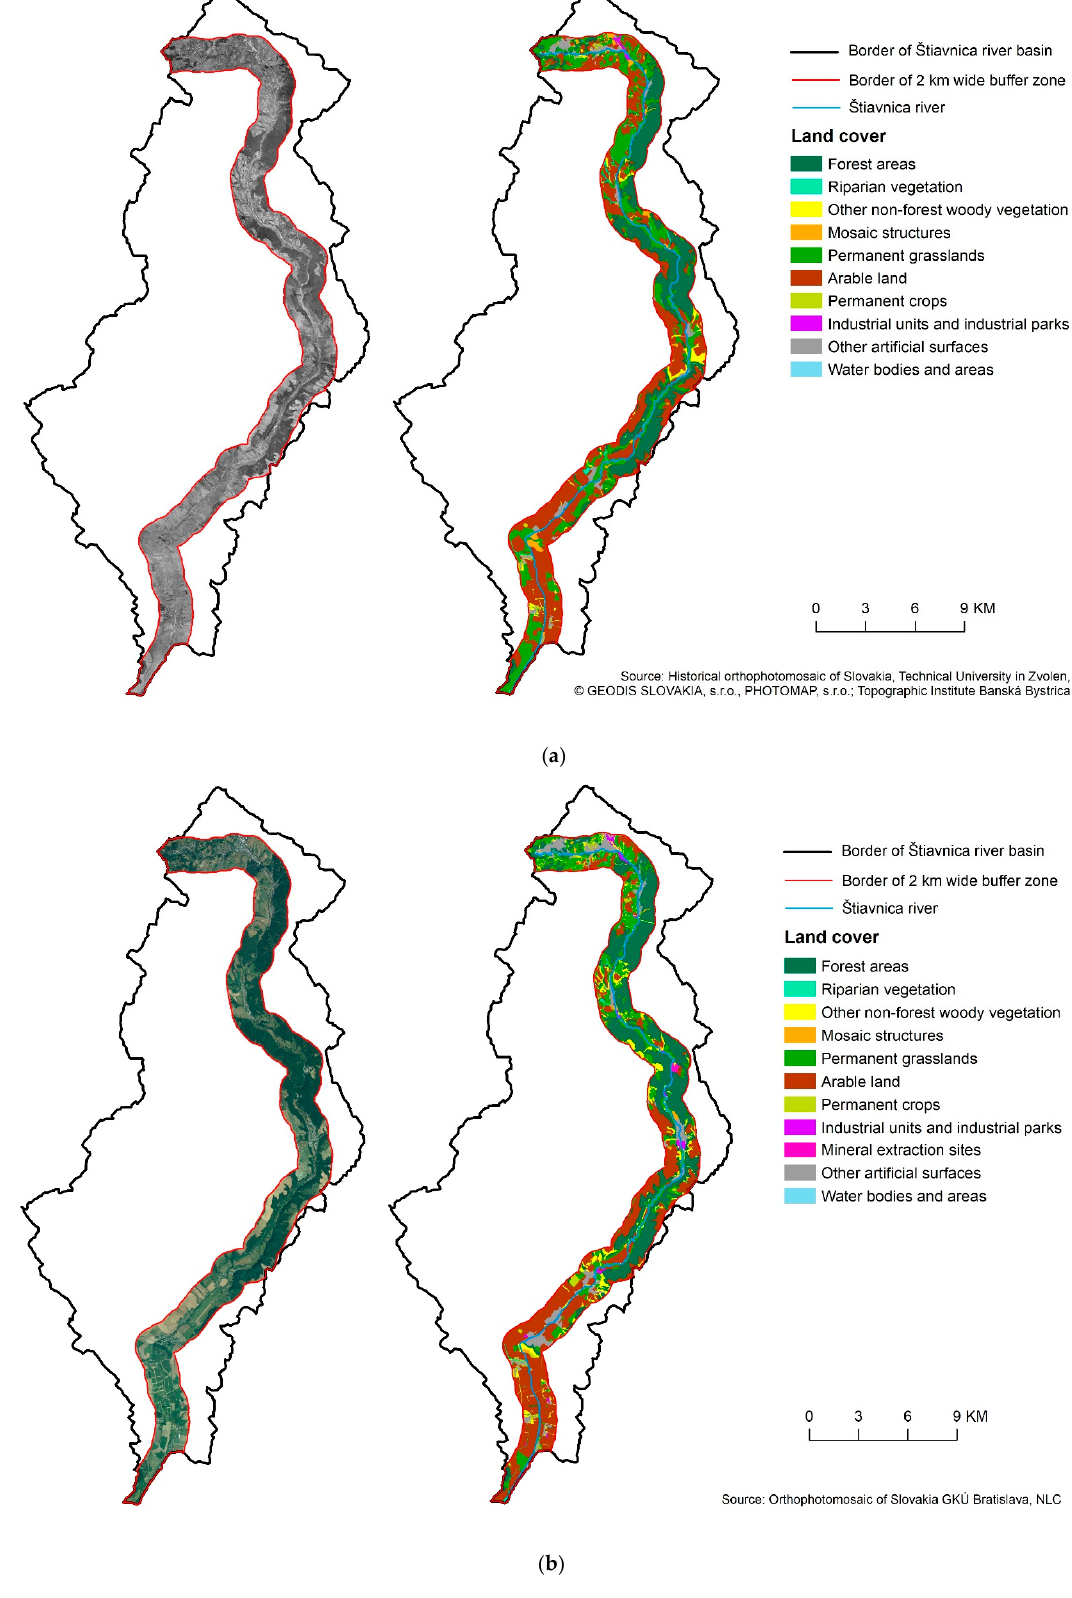
Figure 4. LULC maps for 1950 ( a ) and 2019 ( b ) of the Štiavnica River floodplain. Table 7. LULC patterns for 1950 and 2019 of the Štiavnica River floodplain.